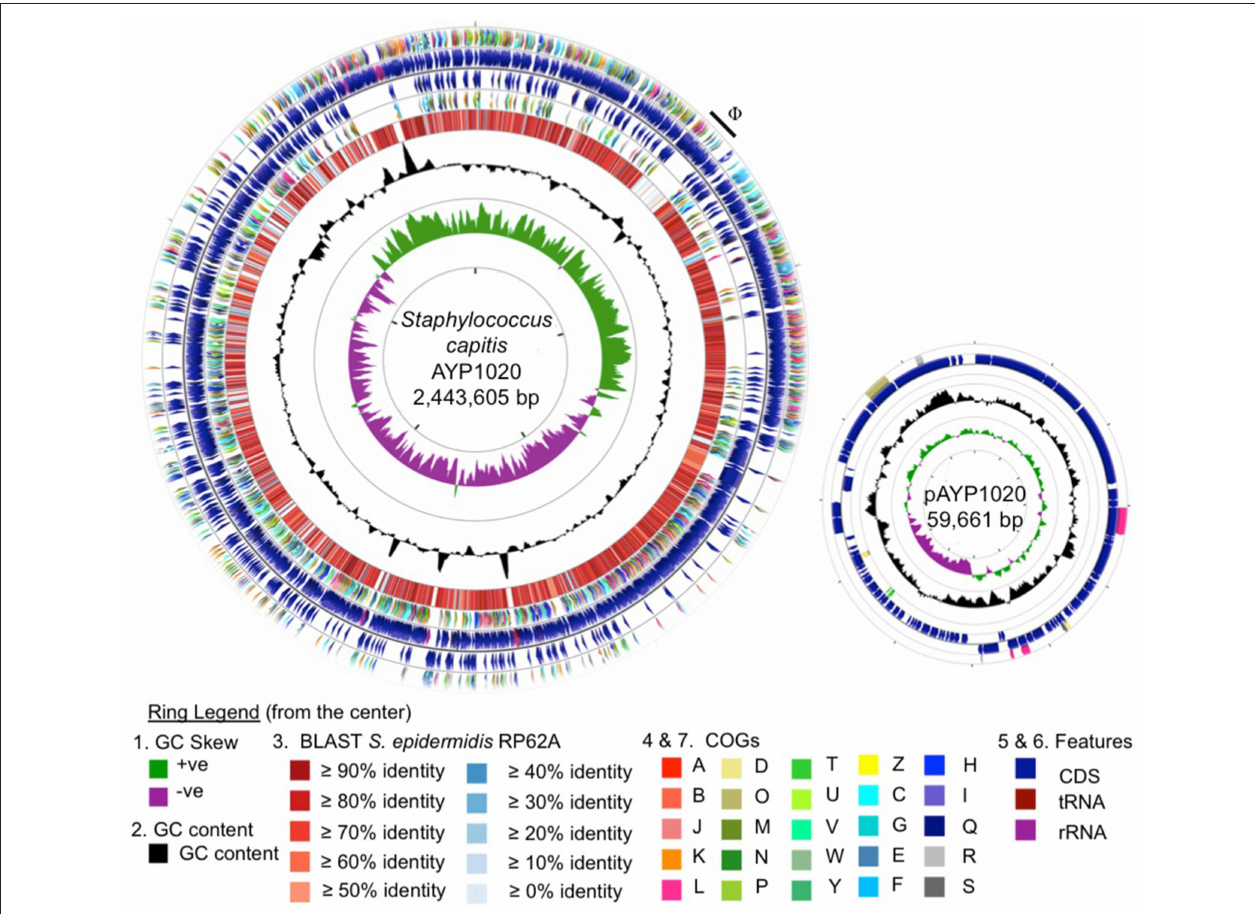
FIGURE 2 | Circular representation of the S. capitis AYP1020 chromosome and its plasmid, pAYP1020. For the chromosome, the first (innermost) ring indicates the GC skew, followed by the GC content (second ring). The third ring indicates the degree of amino acid identity across all CDS of S. capitis AYP1020 compared to S. epidermidis RP62a, as determined by BLASTp and scaled according to percent identity as indicated in the key ( Altschul et al., 1997). Colored arrows on the fourth and seventh rings represent the following COG categories ( Tatusov et al., 2000); A, B, J, K, L, information and storage and processing; D, O, M, N, P, T, U, V, W, Y, Z, cellular processes and signaling; C, G, E, F, H, I, Q, metabolism; R and S, poorly characterized, on the reverse and forward strands, respectively. The fifth and sixth rings represent the CDS (blue), tRNA (maroon), and rRNA (purple) on the reverse and forward strands, respectively. For the genome, the scale displayed in the center of the graphic represents 500kb. For the plasmid, the scale represents 5kb. The images were generated using CGview (Grant et al.,